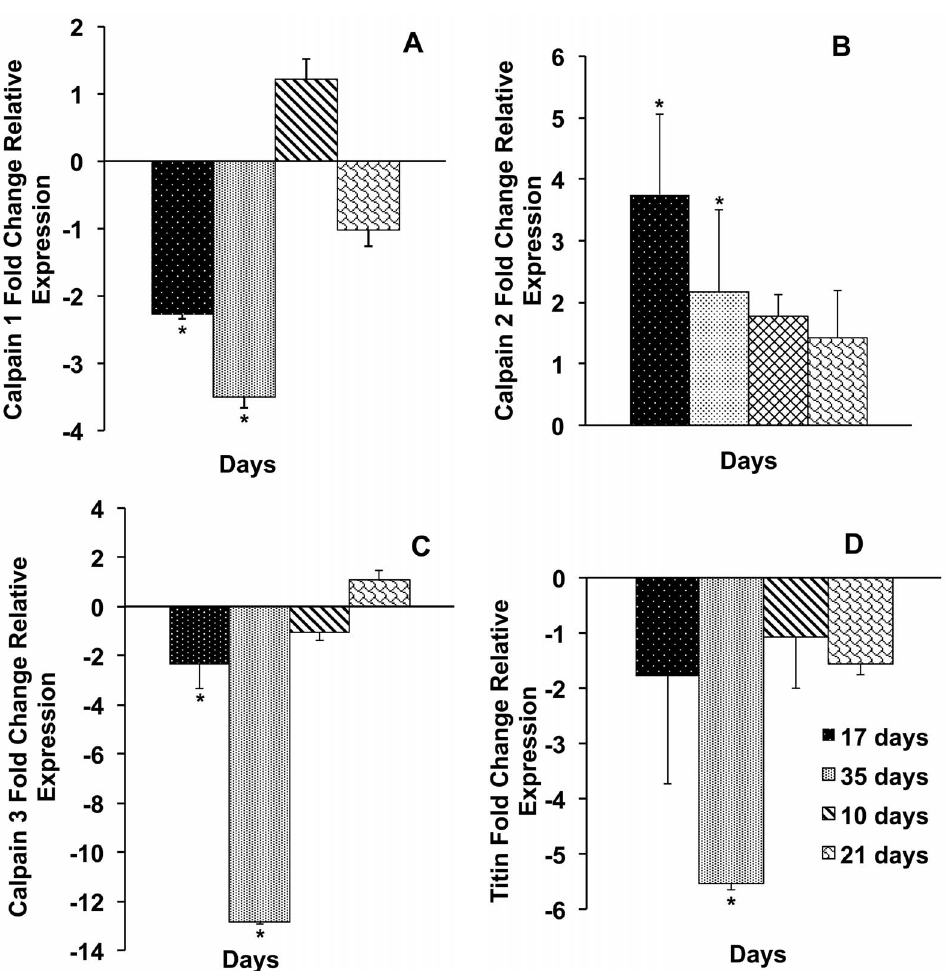
Figure 4. Effect of starvation and re-feeding on catfish muscle clpn1 , clpn2 , clpn3 , and titin genes expression. Real-Time RT-PCR analysis of catfish ( Ictalurus punctatus ) clpn1, clpn2, clpn3 , and titin transcripts abundance in the muscle after 17 and 35 days of starvation and then after 10 and 21 days of re-feeding. Fold change indicates the ratio of gene expression, all compared with t0, and normalized using an internal reference gene (catfish b -actin). The statistical analysis was conducted using the software REST. The bars indicate mean expression of 3 tested pools of 5 fish each 6 SD. Asterisks indicate significant difference (P , 0.05).